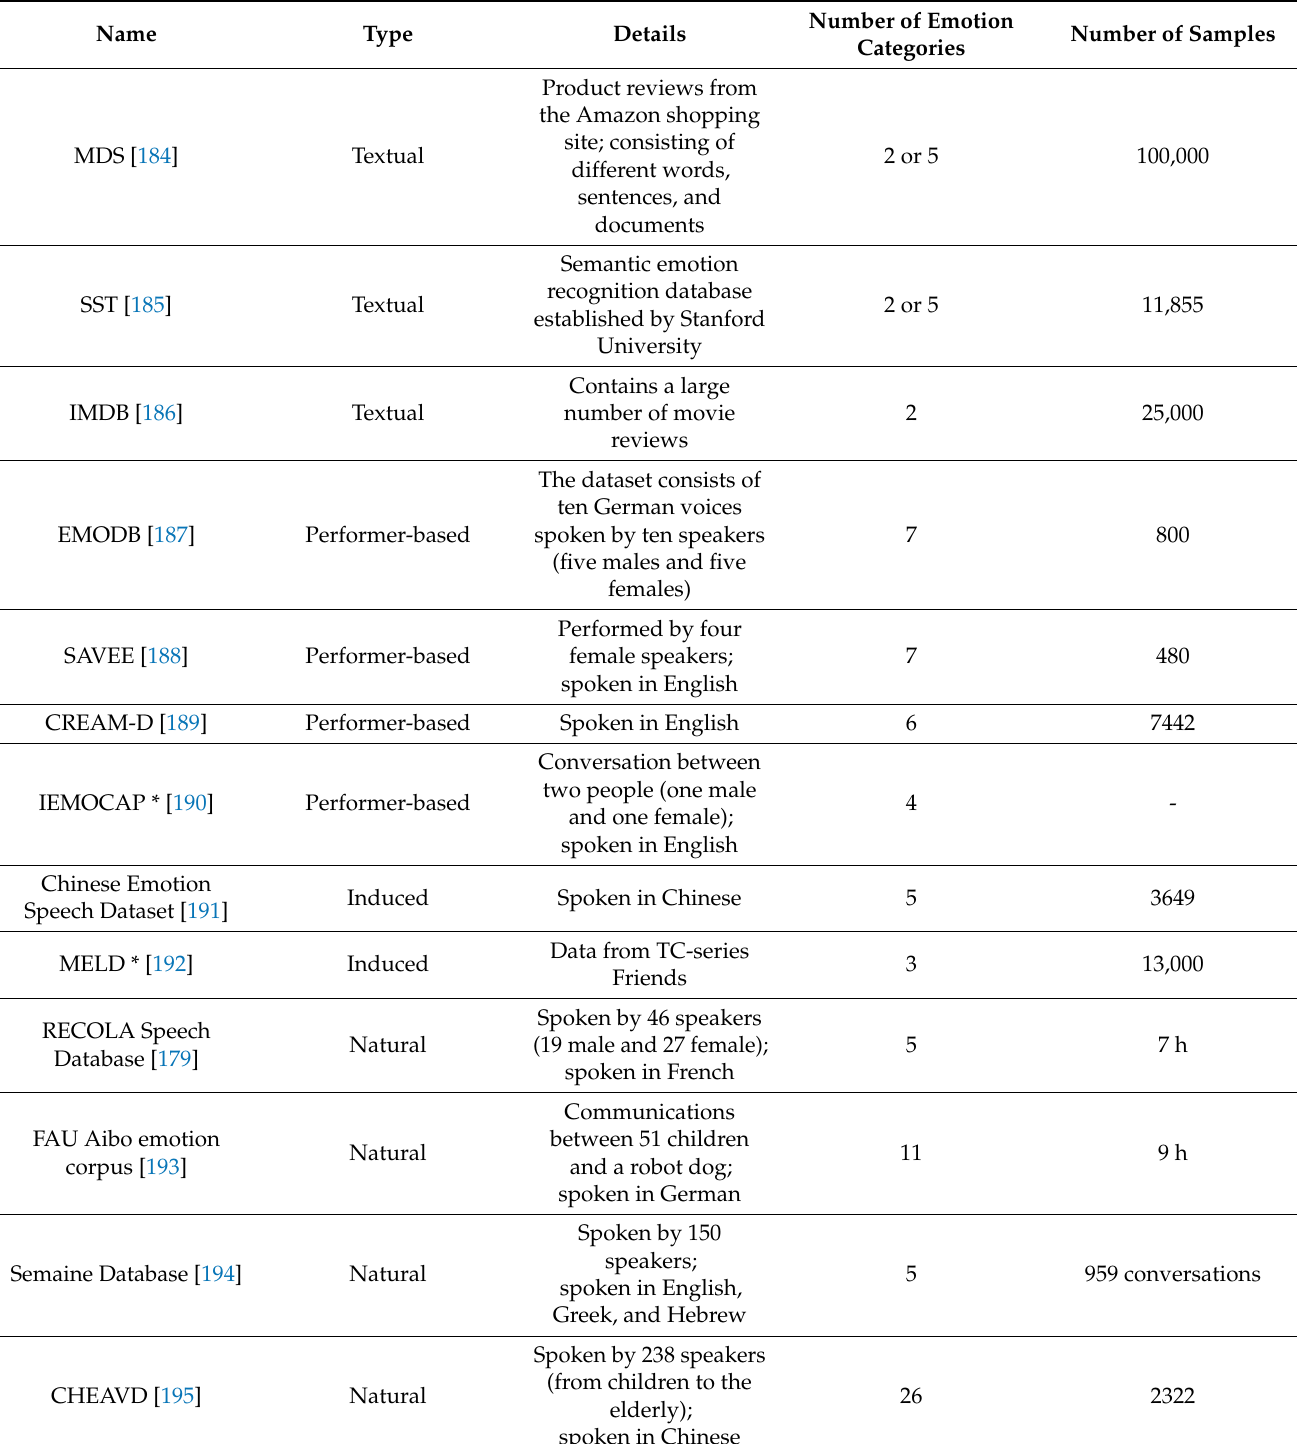
Table 3. Dataset for speech emotion